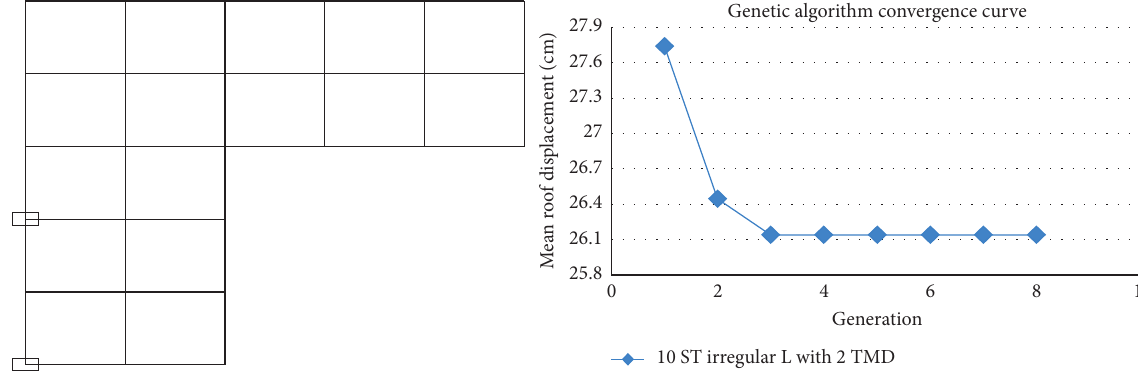
Figure 20: Convergence diagram of the ten-story model with 4 dampers in genetic algorithm (right) and damper optimal position (left).